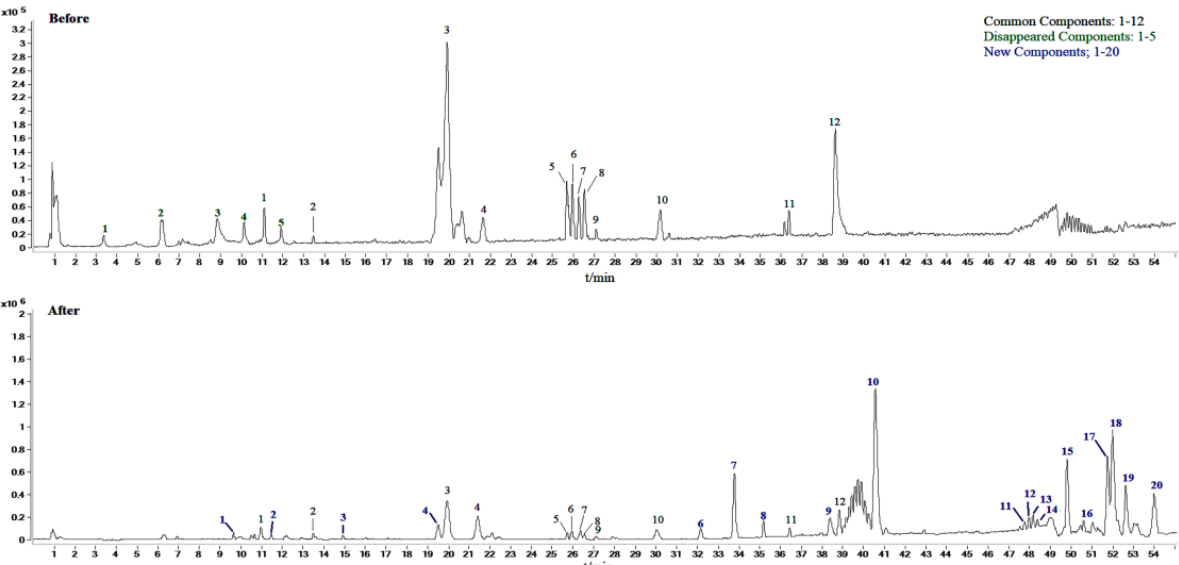
Figure 2. Positive-ion chromatogram of Sanguisorba officinalis L. before ( Sraw ) and after ( Sprocessed ) processing.